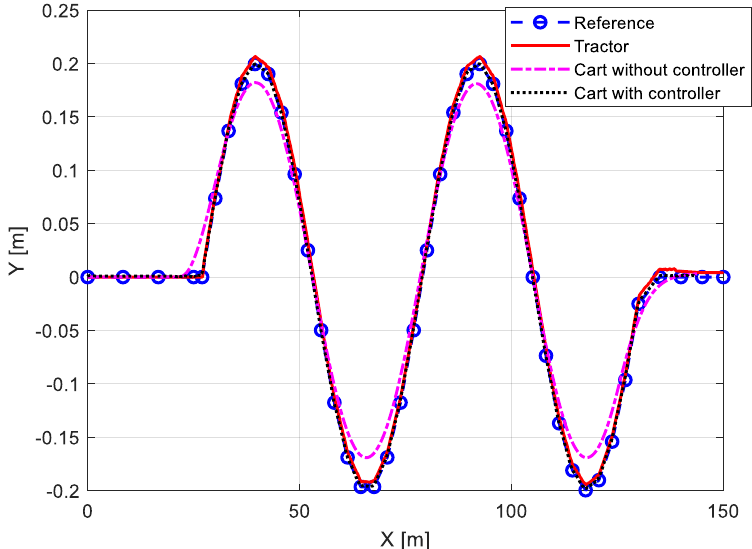
Figure 11. Performances of tractor-cart position control system under a sinusoidal pattern at 1 [m/s] .